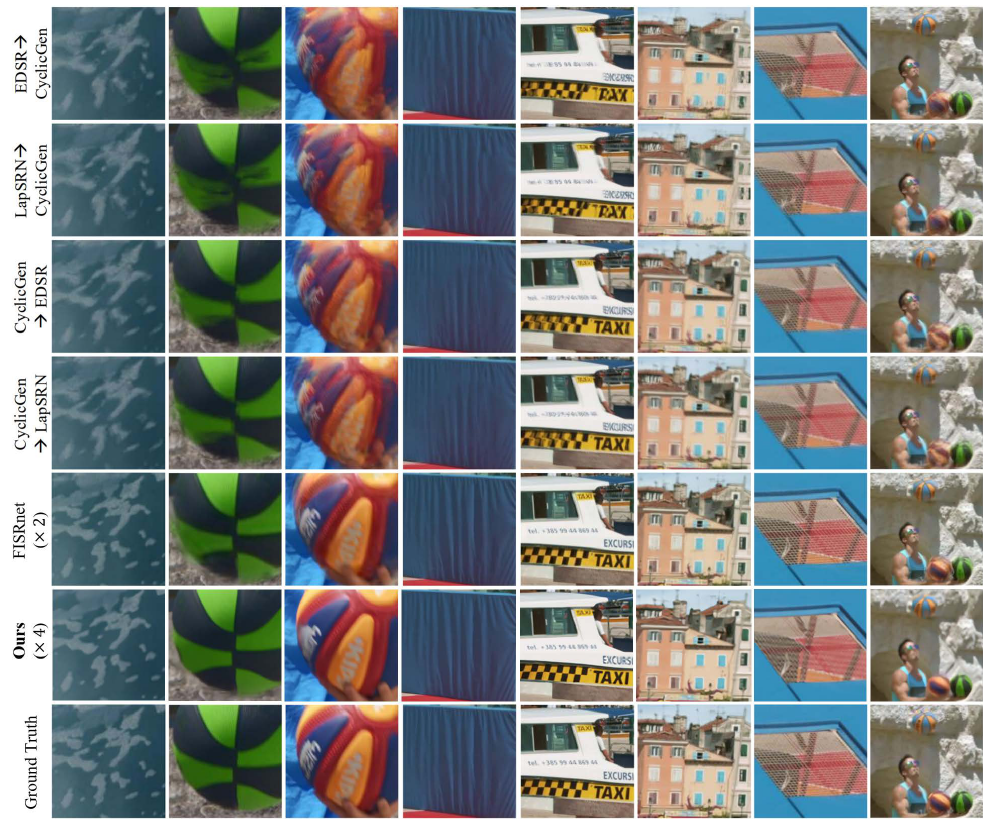
Figure 6. Visual comparison to FISR [32] ( × 2) and our method ( × 4) along with additional baselines. Despite the disadvantage of our method performing × 4 spatial upsampling compared to × 2 for the other methods, our approach shows even favorable visual quality if not comparable. We compare with the visual results displayed in the FISR [32] paper. The other methods show bleeding (2nd column) or ghosting artifacts (3rd column) while our method does not. Reprinted/adapted